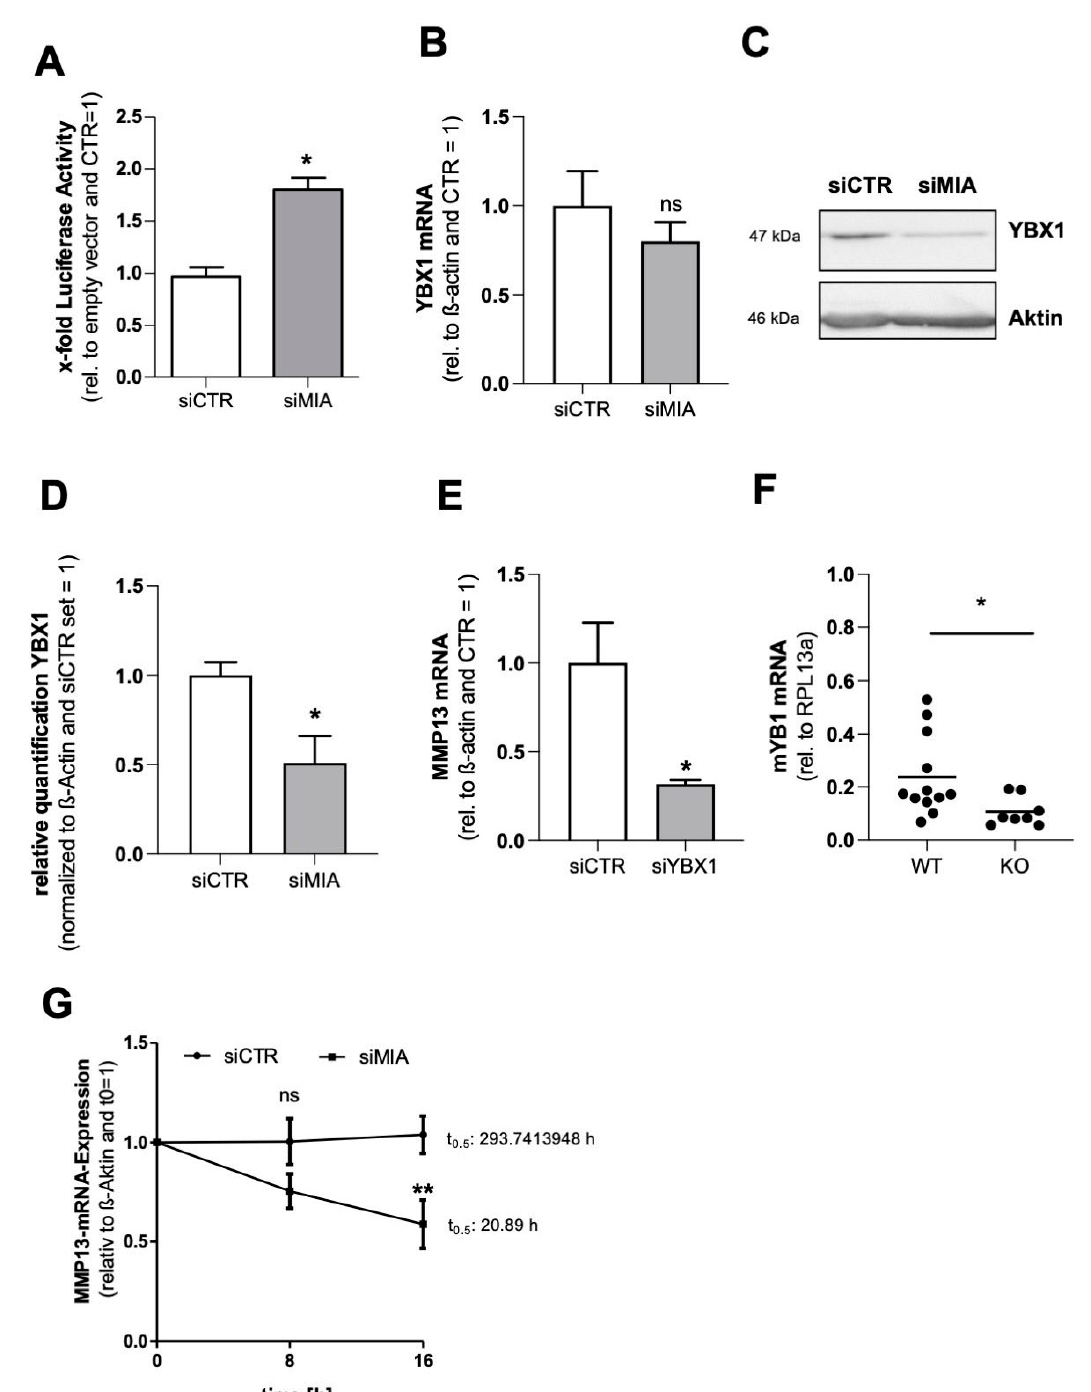
Figure 3. ( A ) MMP13 promoter activity in siCTR- and siMIA-transfected cells ( n = 5). ( B ) Quantitative RT-PCR analysis of YBX1 after siMIA transfection in comparison to siCTR ( n = 3). ( C , D ) Representa- tive Western blot images and quantification depicting YBX1 protein levels after transfection siMIA ( n = 4). ( E ) Quantitative RT-PCR analysis of MMP13 levels after siYBX1 transfection in comparison to siCTR ( n = 4). ( F ) Quantitative RT-PCR analysis of YBX1 expression levels in murine chondrocytes (WT = wildtype, KO = knockout). ( G ) MMP13 mRNA in SW1353 after transfection with siCTR and siMIA, respectively and treatment with 10 µ g/mL actinomycin D for 8 and 16 h. MMP13 levels were normalized to β -Actin and an untreated control ( n = 5) (two-way ANOVA) (**: p < 0.005). Bars are shown as mean ± SEM (Student’s t -test). (*: p < 0.05, ns = not